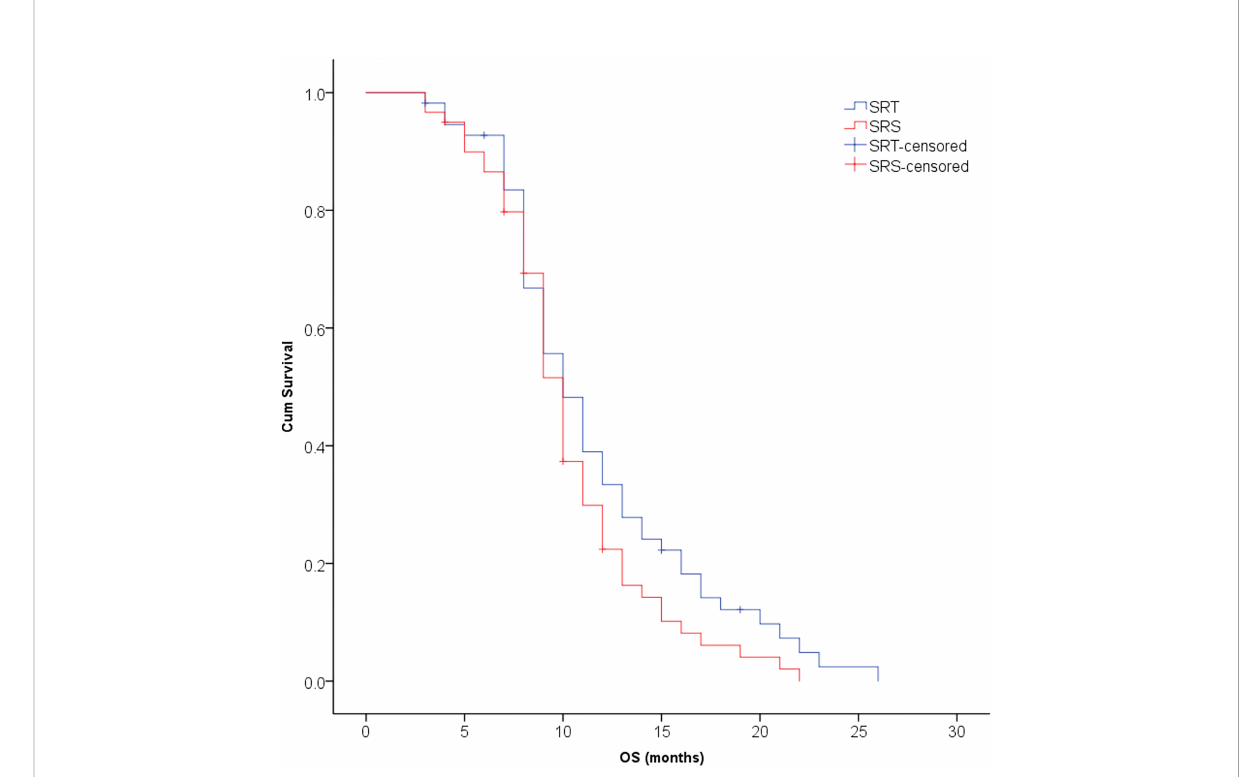
FIGURE 2 No signi fi cant difference was observed in overall survival between the SRT and SRS groups (P =